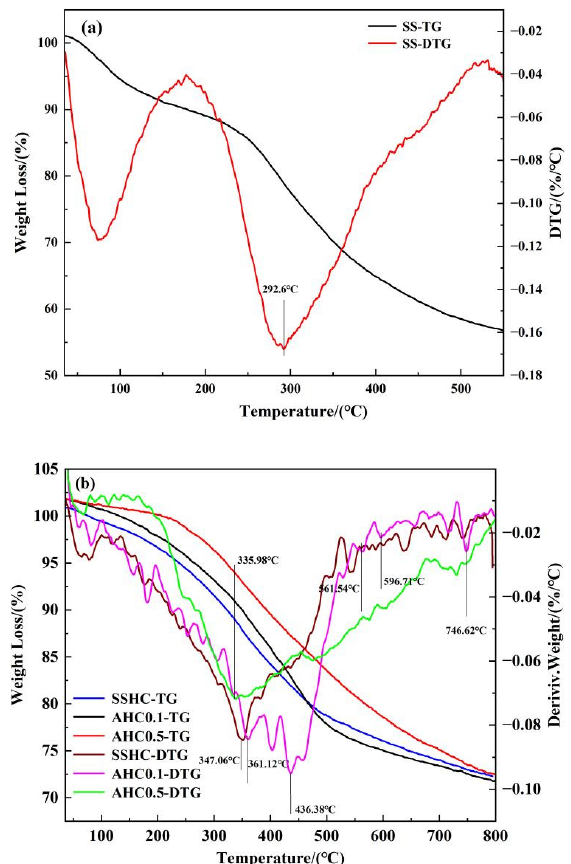
Figure 6. TG/DTG curves of SS ( a ) SSHC, AHC0.1, and AHC0.5 ( b ).